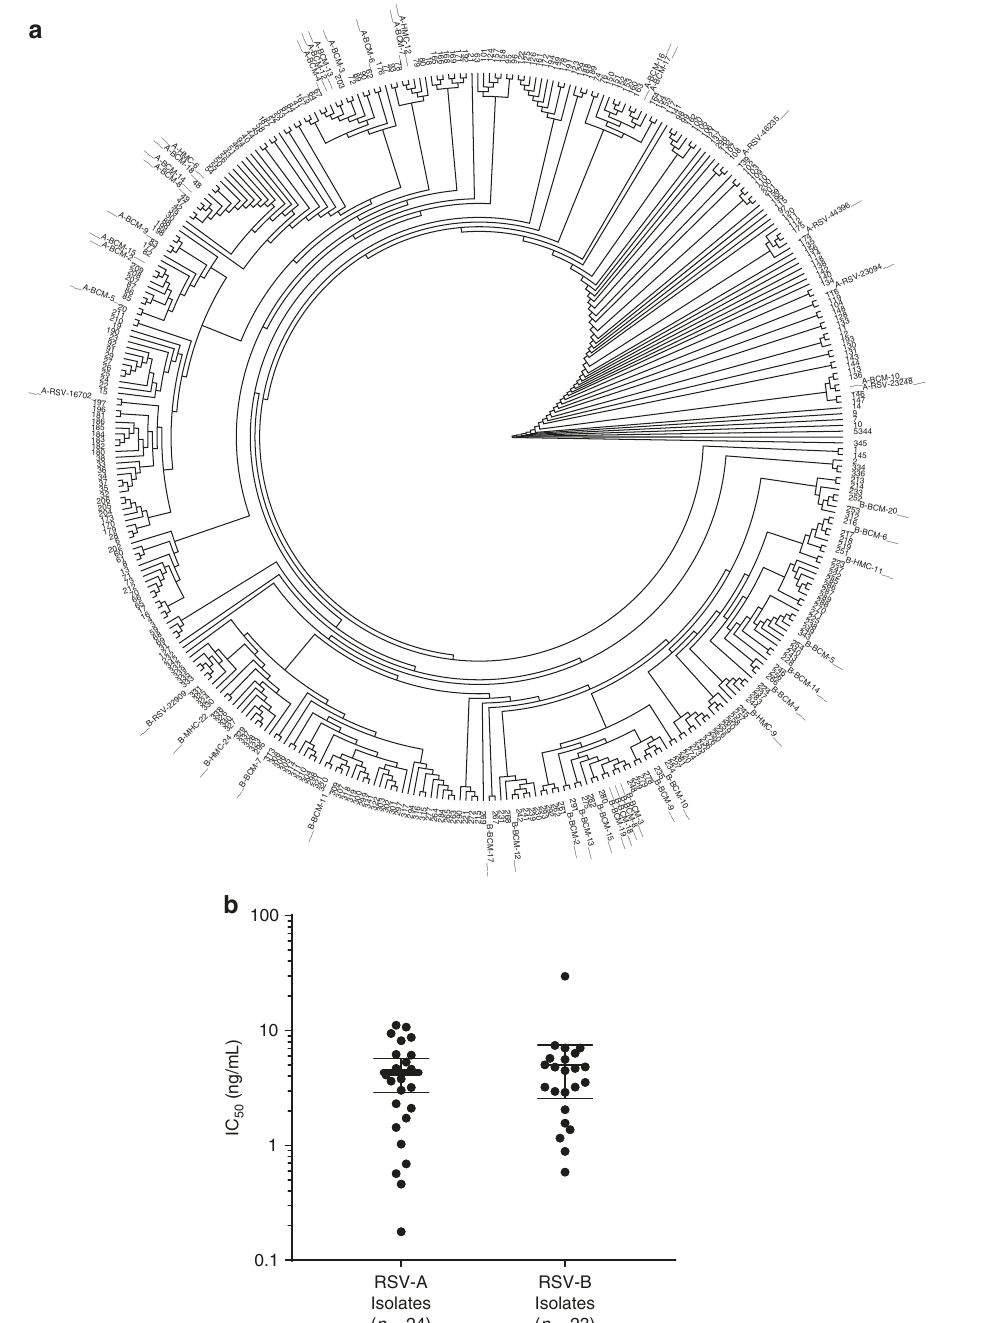
Fig. 2 Neutralization of a diverse set of clinical isolates. a The clinical isolates used to evaluate RB1 neutralization activity were displayed as a dendrogram to evaluate sequence diversity. A phylogenetic tree of 345 unique GenBank sequences is represented in the inner part of the circle while the fusion protein sequences of 46/47 RSV A and B clinical isolates are marked as spokes on the outside of the circle (1 clinical isolate contained an incomplete sequence). Source data (clinical isolate sequences and accession numbers) are provided as a source data fi le. b RB1 was assessed for its ability to neutralize RSV clinical isolates using an in vitro microneutralization assay. A panel of 47 RSV clinical isolates containing amino acid changes in the F fusion glycoprotein were tested in the in vitro neutralization assay. IC 50 was calculated and represents the concentration of antibody required for a 50% reduction in the RSV infectivity. The error bars represent the geometric mean with 95% con fi dence intervals